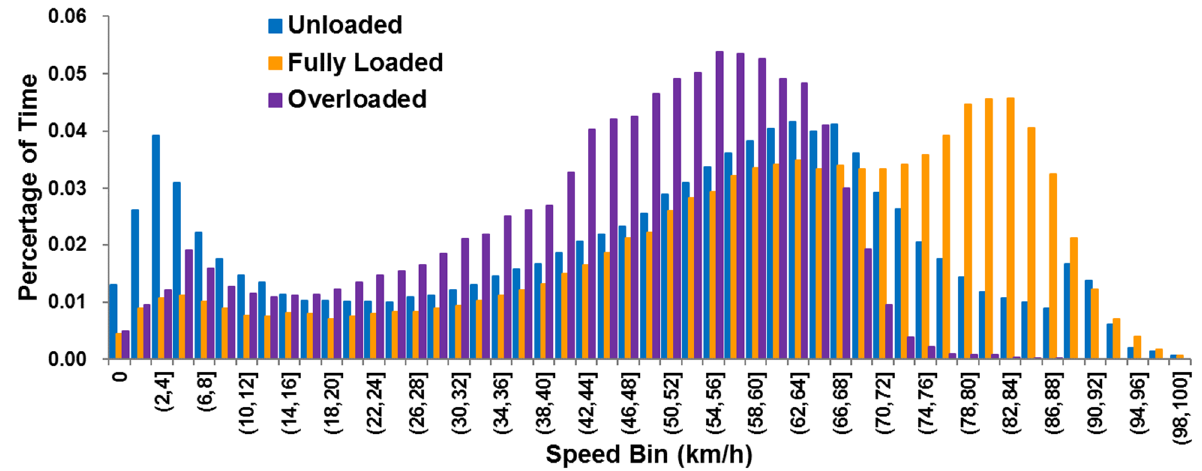
Figure 2. Time percentage of operating speed for trucks under unloaded, fully loaded and overloaded states in each speed bin.